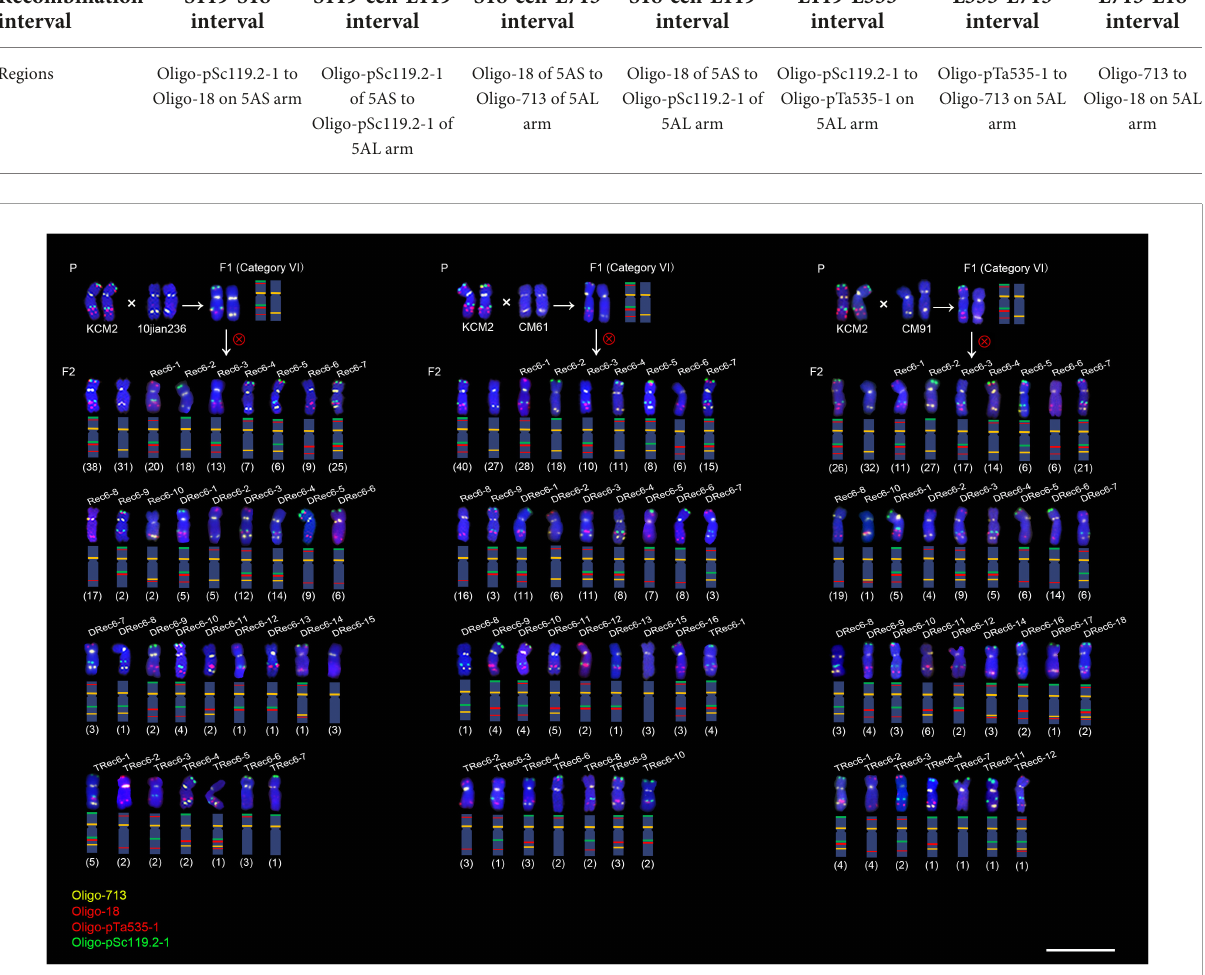
FIGURE3 Fluorescence in situ hybridization signal patterns of the 5A chromosomes in progeny of three hybrid combinations of category VI. “P” indicates parental plants. “F1” indicates F 1 generation. “F2” indicates F 2 generation. Rec6-n, DRec6-n and TRec6-n represent the single recombination, double recombination and triple recombination, respectively. The numbers in parentheses indicate the number of each type of 5A chromosome. The schematic representation of each chromosome is shown. Scale bar, 20 µ m.